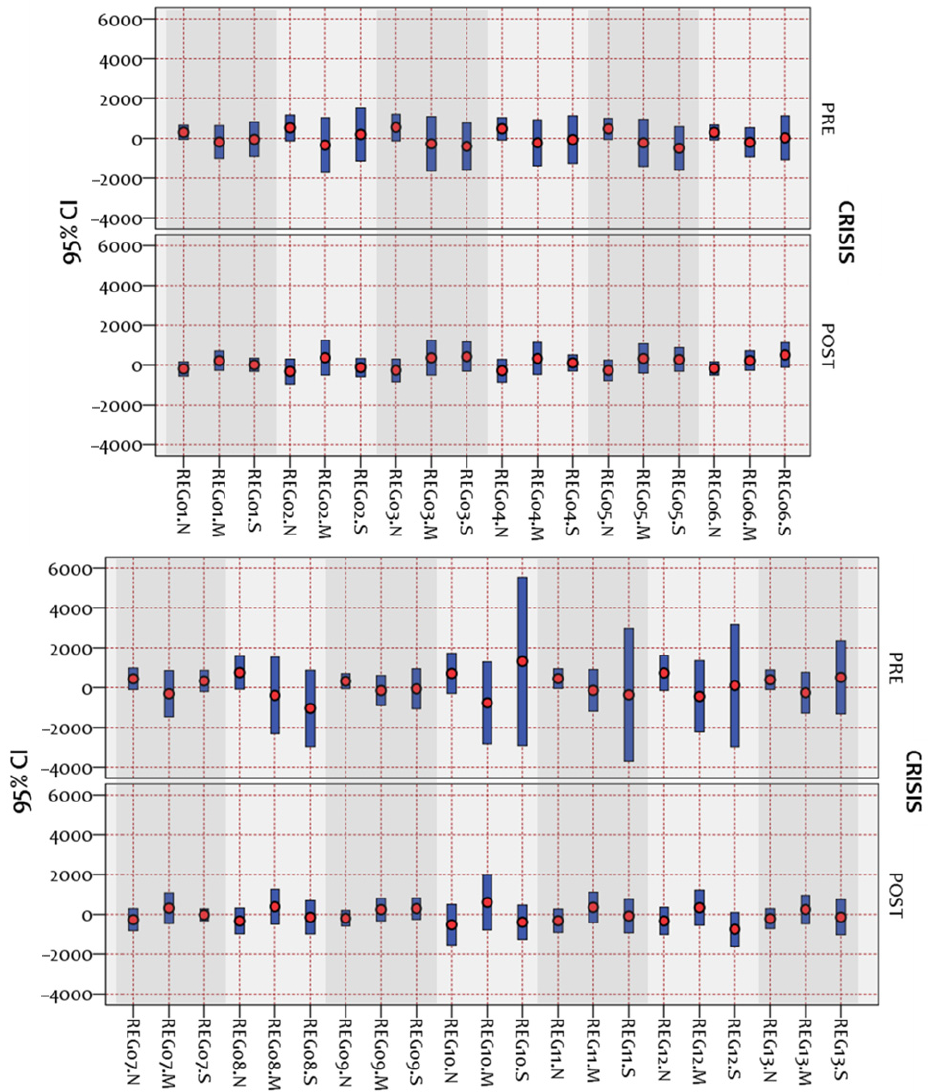
Figure 8. Error bars of 95% CIs of the pre-and on-crisis mean values of the shift-share analysis components (R, N, M, and S), for the 13 (NUTS II) Greek regions (the measures’ computations applied across annual GVA (pLU). GVA prices are measured in EUR/LU (constant prices on 2008 basis).